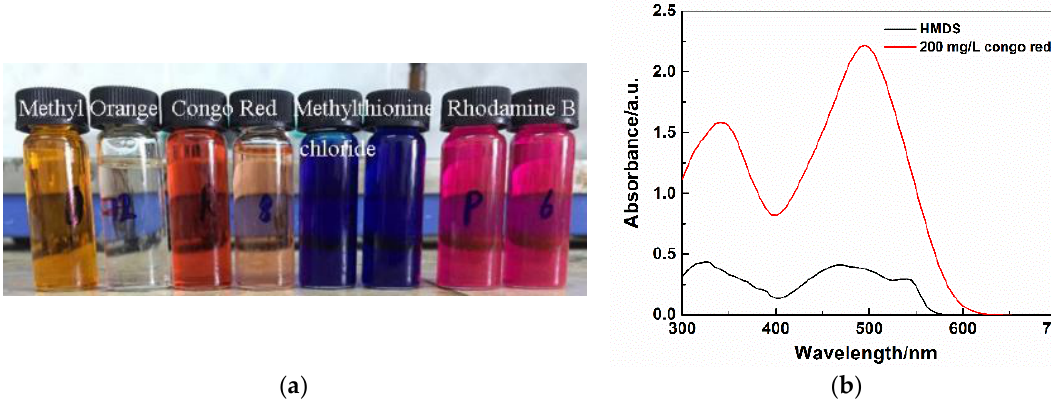
Figure 14. ( a ) Digital camera image of different dye solutions before and after absorption of flexible